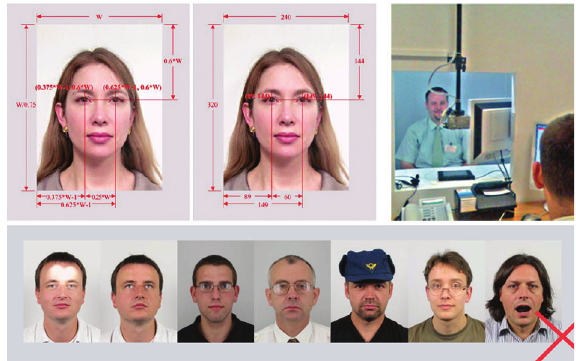
Figure 3: On the top left: an example of ideal facial photo with measures; top right: the Czech endpoint station from the o ffi cers’ view; bottom: unacceptable facial photos (sources: [5,